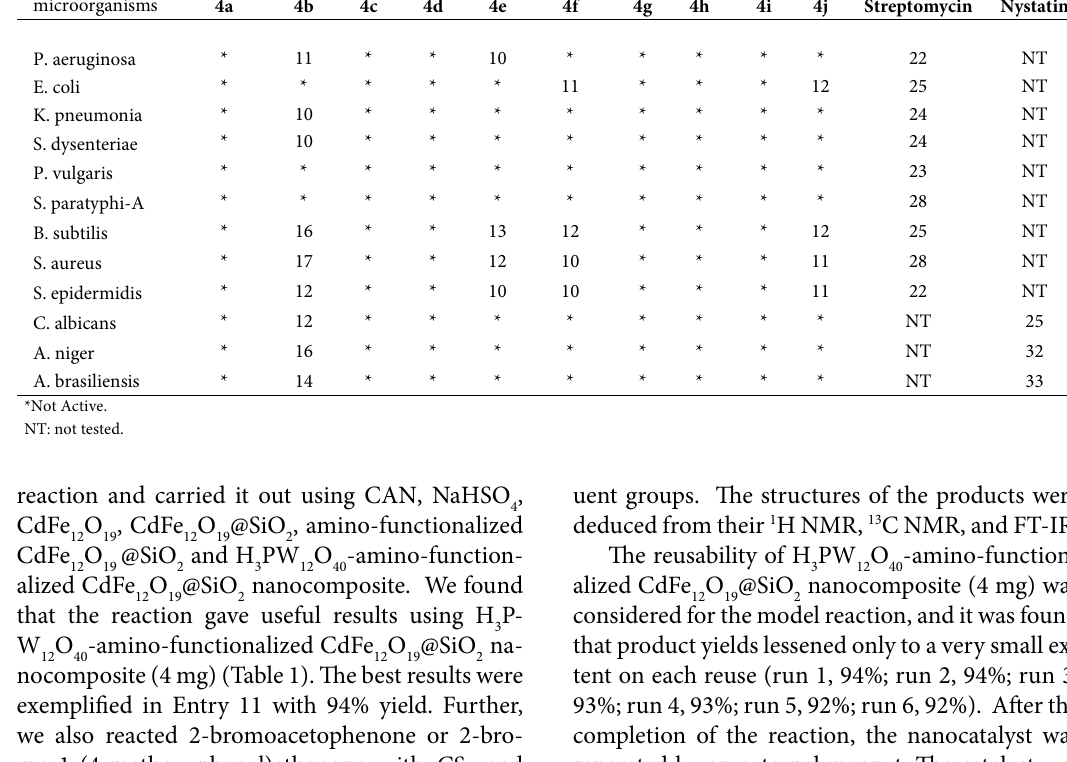
Table 3. In vitro antimicrobial activity of the compounds using agar diffusion assay Test microorganisms